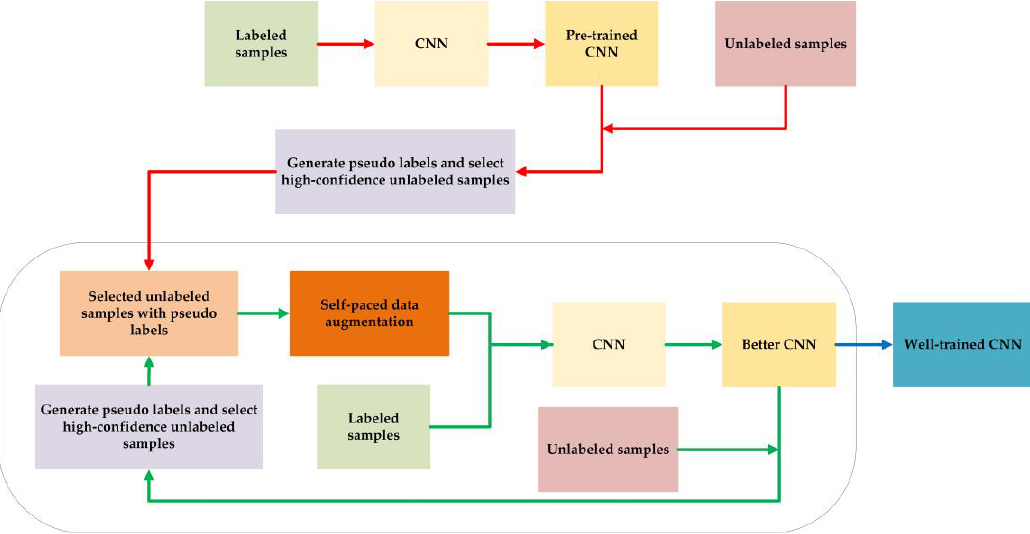
Figure 1. The flow chart of our proposed